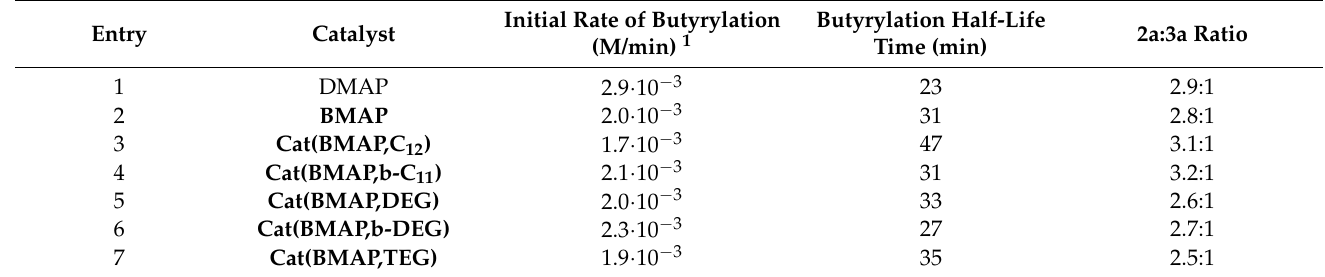
Table 5. Butyrylation of substrate 1 , promoted by the catalysts of the BMAP family, as depicted in Scheme 3, in the presence of butyric acid additive 1